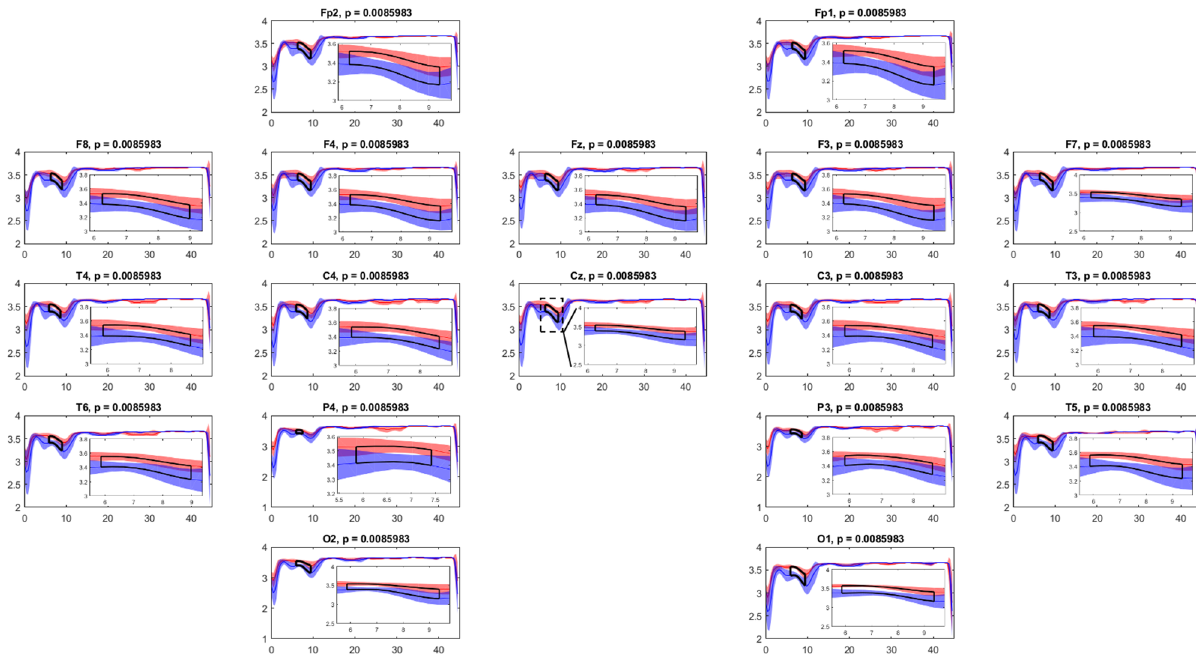
Fig 4. Result of the permutation test. Mean and confidenceinterval of the LSE for epilepticpatients group 1 and group 2 in red and blue respectively.Interval of statistical significance in black. We show zoomed windowsof significant frequencies overlapping the entire spectral range at each electrode. There exists significancein all channels at p = 0.0086 at least in the range of frequencies [6.25–12.89)Hz.